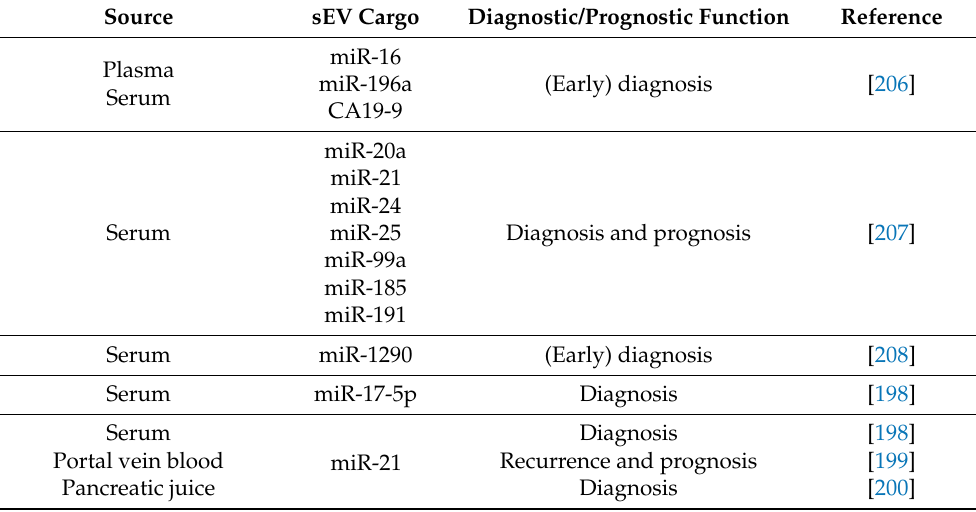
Table 2. sEV biomarkers for diagnosis and prognosis of